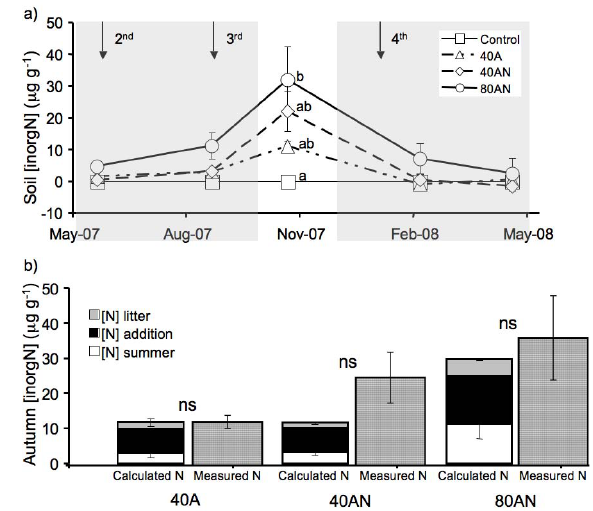
Fig. 4. Soil inorganic N concentration in relation to the control along the experimental period in response to distinct N additions ( a – see material and methods) and comparison between the “cal- culated N” (stacked columns – see material and methods) and the “measured N” (dashed columns) concentrations of soil inorganic N in autumn and according to the N additions (40A, 40AN and 80AN – b ). There were no significant differences between “calculated N” and “measured N” (t-student p < 0.001). Values represent the mean ( n =3 experimental plots per treatment) ±